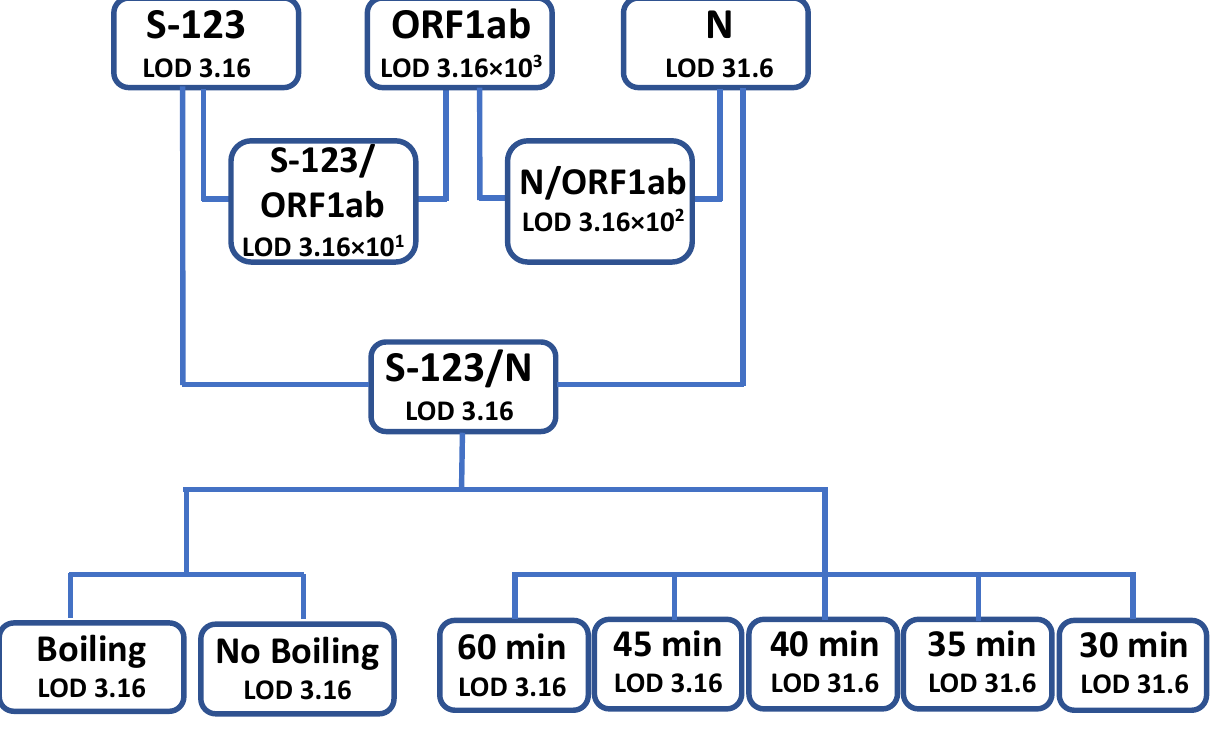
Figure 1. Flowchart demonstrating the limit of detection (LOD) for the methods used in the study including primer regions and sample treatment.